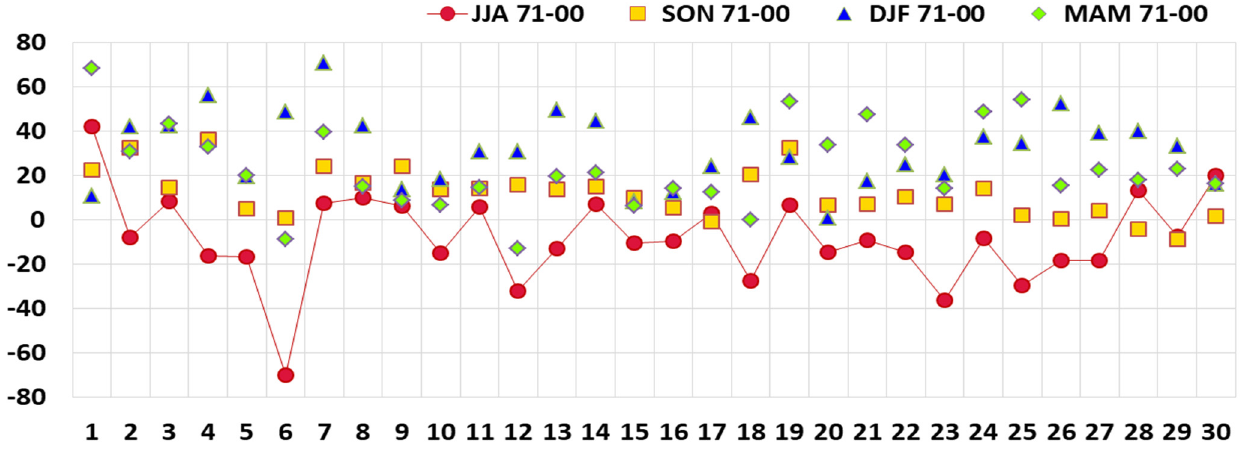
Figure 7. Mean (1971–2000) GCM–RCM seasonal bias of the precipitation field averaged over the Pannonian Basin and compared with the E-OBS gridded dataset. The red line denotes overall bias during summer. Biases are expressed as % of observations. The integration numbers follow the list from Table 1.